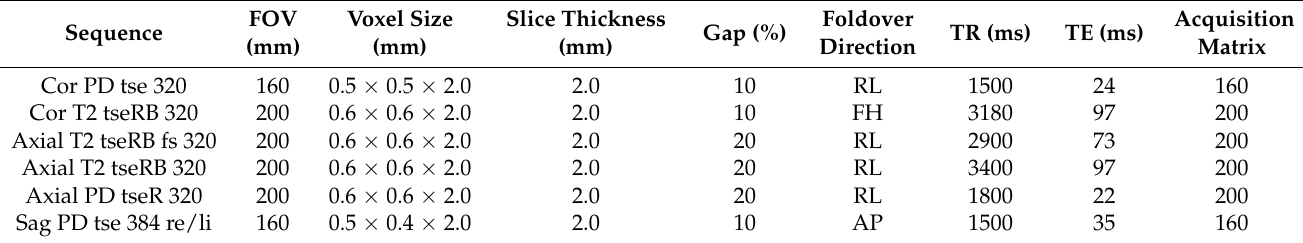
Table 1. Post spica cast pelvic MRI protocol parameters, FOV field of view, fs fat saturation, PD proton density, TE echo time, TR repetition